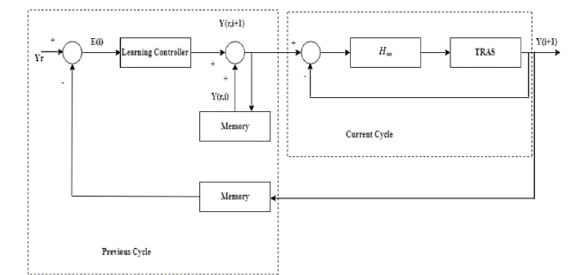
Fig. 4: Closed-Loop Diagram of the Hybrid